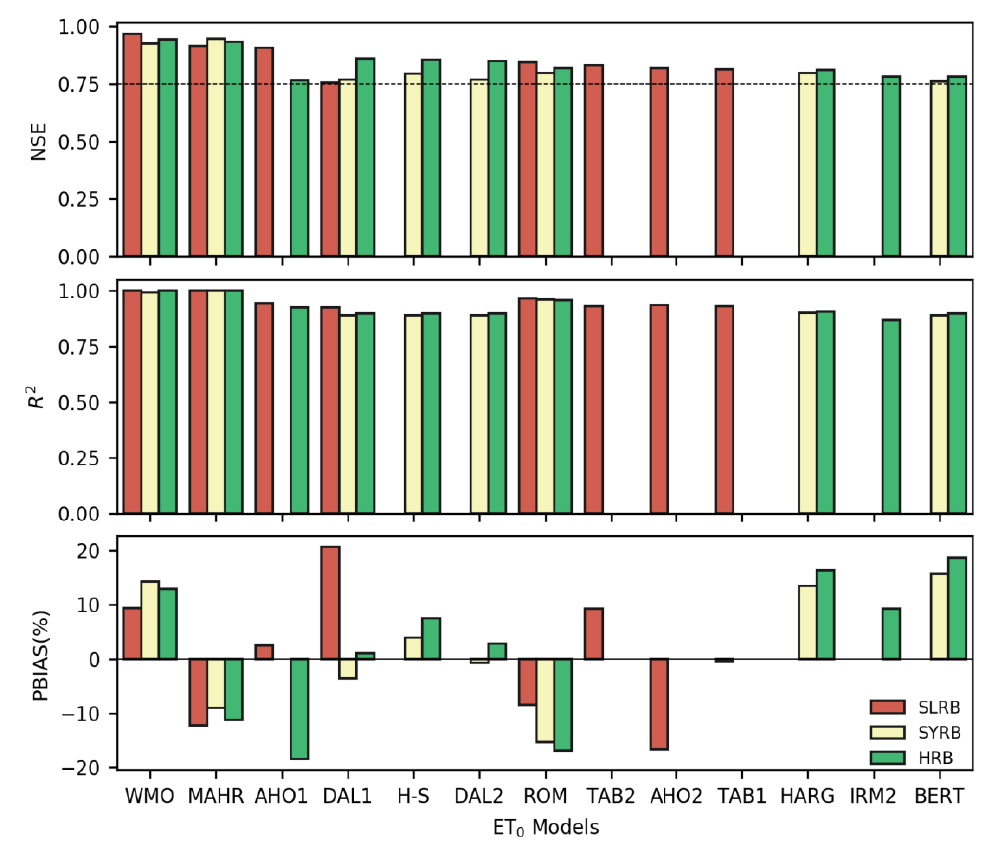
Figure 6. Cross-comparison between 13 robust methods (dash line represents the threshold value for model selection condition, NSE = 0.75).